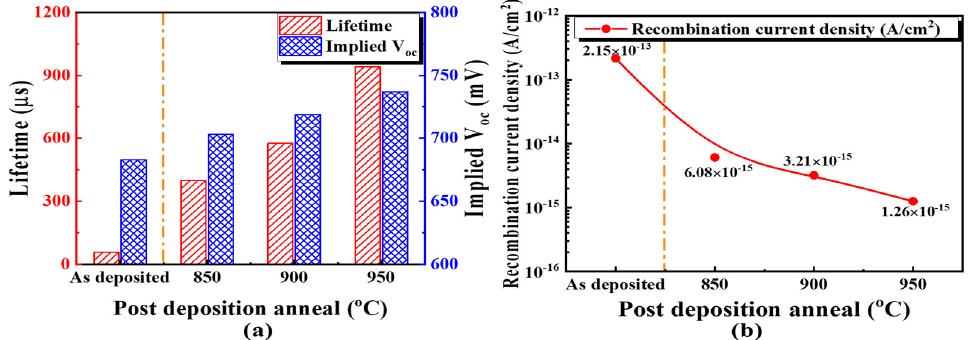
Figure 3. ( a ) Minority carrier lifetime and implied open-circuit voltage as functions of T PDA at 30 nm nc-SiO x layer thickness. ( b ) Recombination current density as a function of T PDA.